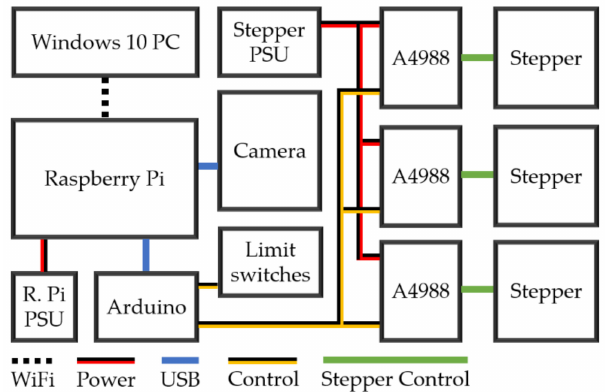
Figure 3. The electronic architecture used for the three-axis linear robot. The Arduino and A4988 motor drivers were soldered onto the same PCB, with the motors, limit switches, Raspberry Pi and power supply connected via header pins, DC connectors and